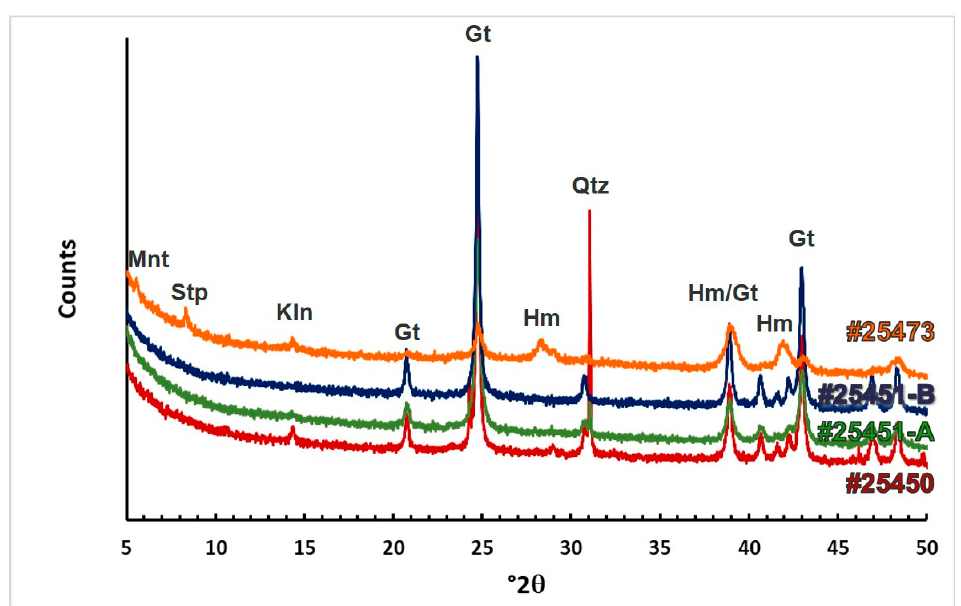
Figure 17. X-ray diffraction (XRD) patterns, over the 5–50° 2 θ angle-range, of the >300 μ m fraction of drill core material selected from each pisolith for (U-Th)/He-dating. The main peaks of minerals identified in each sample are labelled following mineral abbreviations recommended by [28]. Mineral